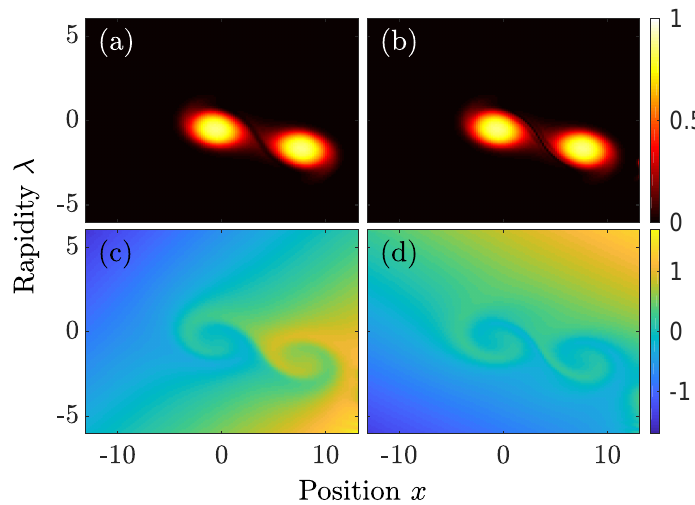
Figure 2: Demonstration of the solution by characteristics in eq. (12). (a) Filling function after five periods ϑ ( t , x , λ ) . (b) Initial filling function interpolated to final characteristics ϑ ( 0, U ( t , x , λ ) , W ( t , x , λ )) . This indeed reproduces the filling final final shown in (a) . The characteristics U and W rescaled by their initial max value are de- picted in (c-d) respectively. The spiral patterns are a result of the interaction between the